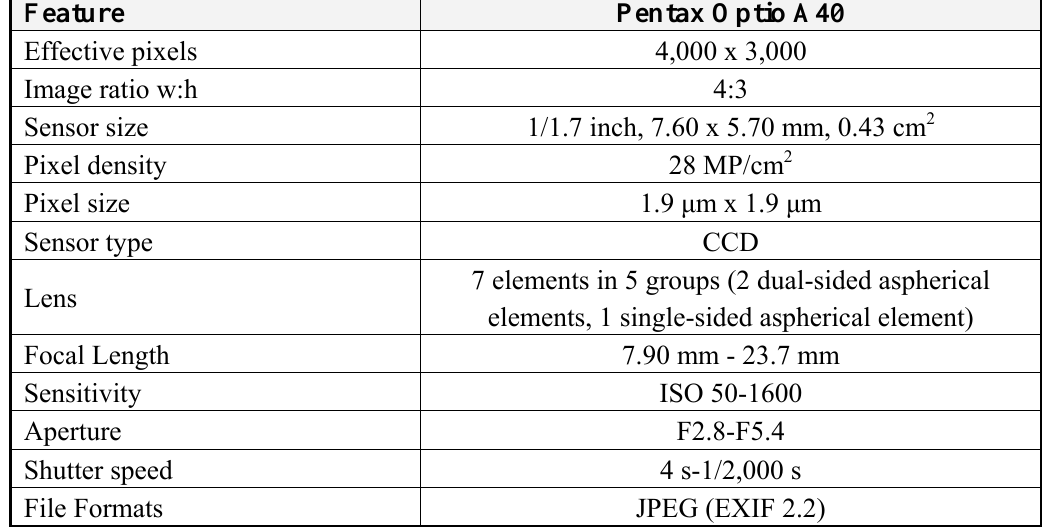
Table 2. Technical characteristics of cameras used in the measurement system (from